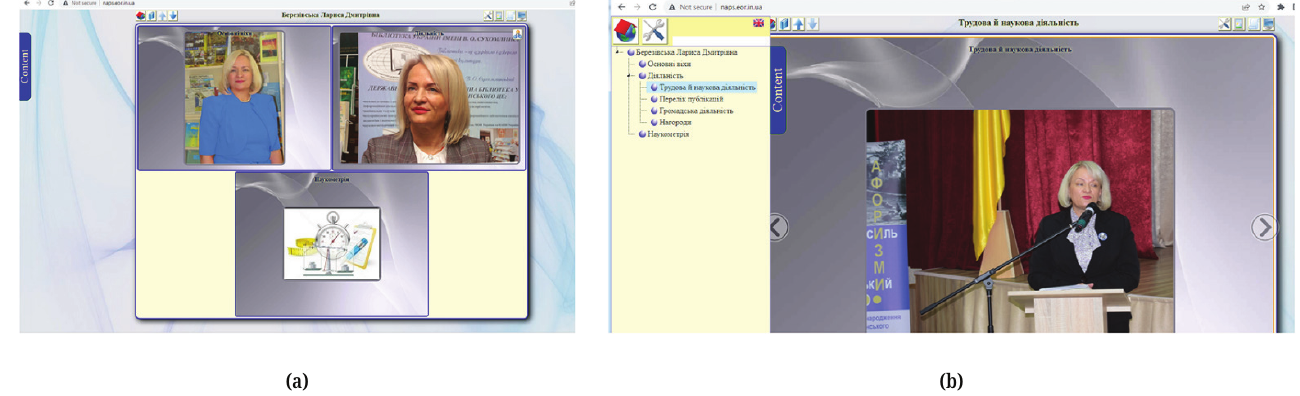
Fig. 7. ONTOS viewer